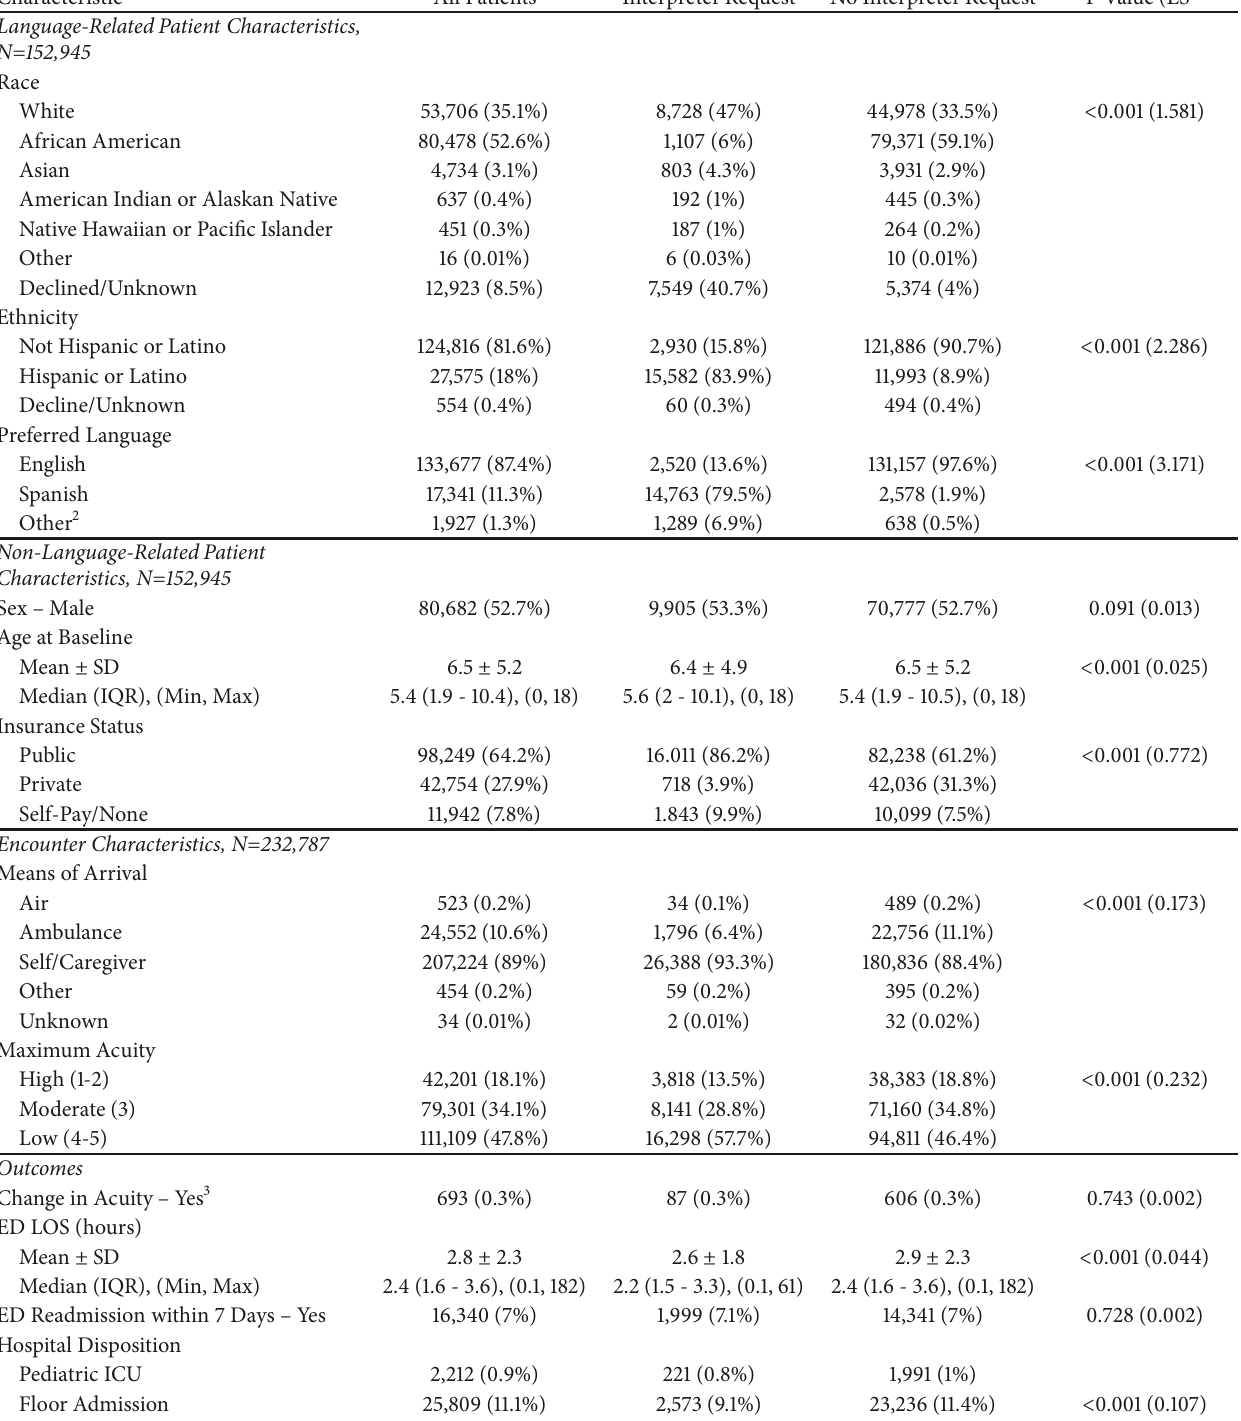
Table 1: Patient and encounter characteristics overall and by interpreter